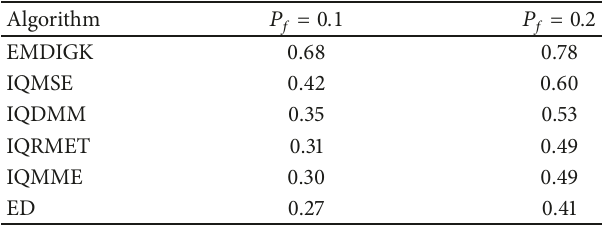
Table 3: The 𝑃 𝑑 of different methods in 𝑆𝑁𝑅 = −16